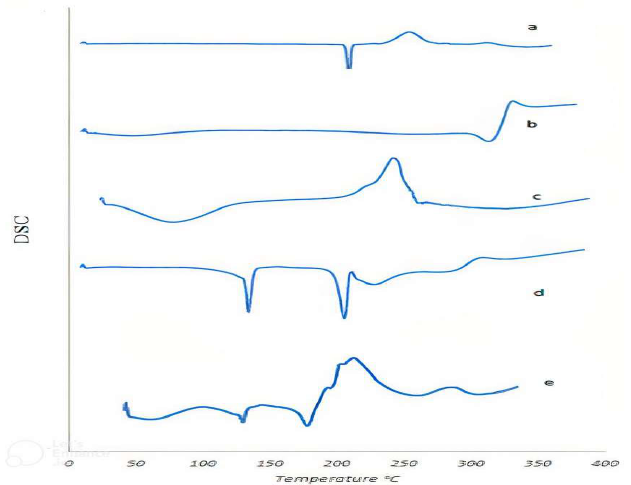
Figure 6. Differential scanning colorimetry for ( a ) CLZ, ( b ) avecil, ( c ) sodium alginate, ( d ) lactose, and ( e ) physical mixture.